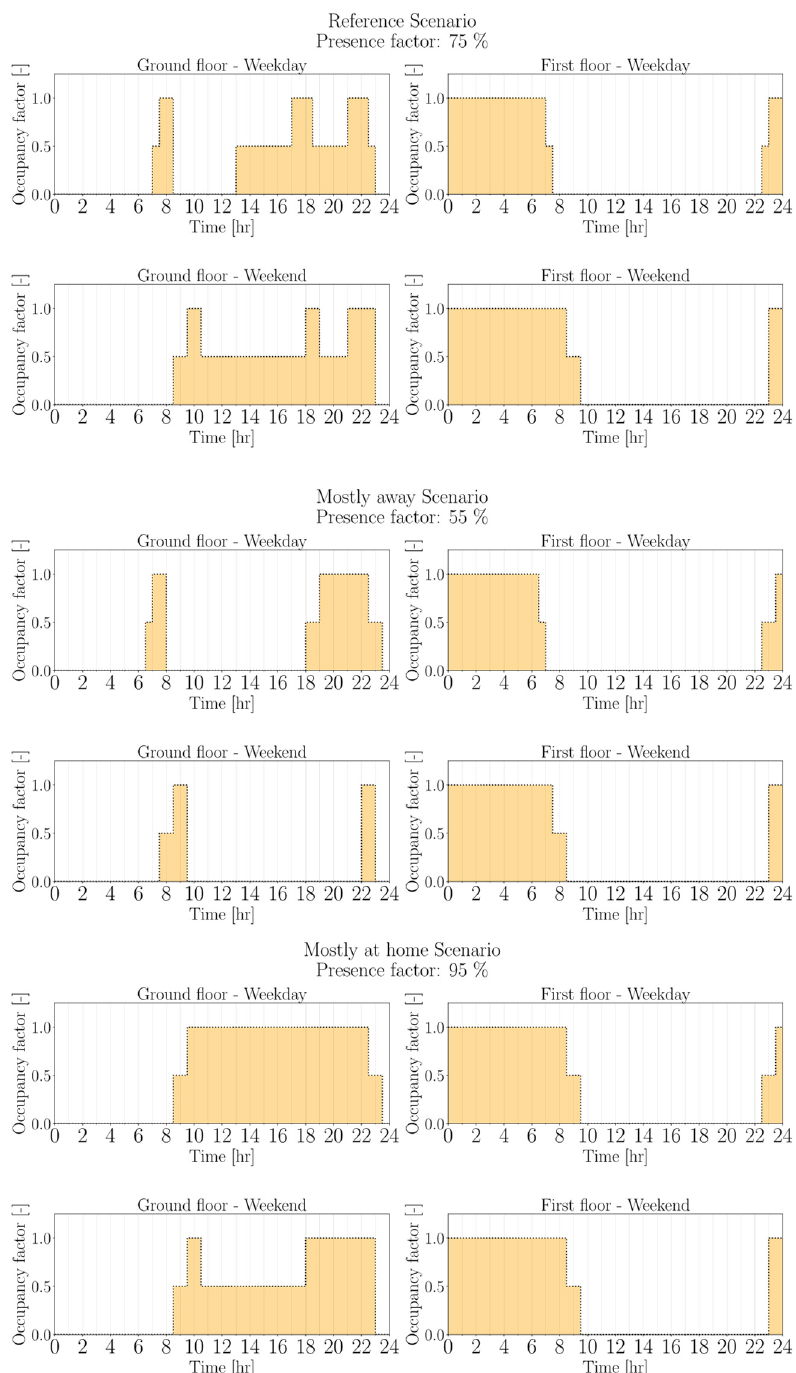
Figure A1. Occupancy profiles.